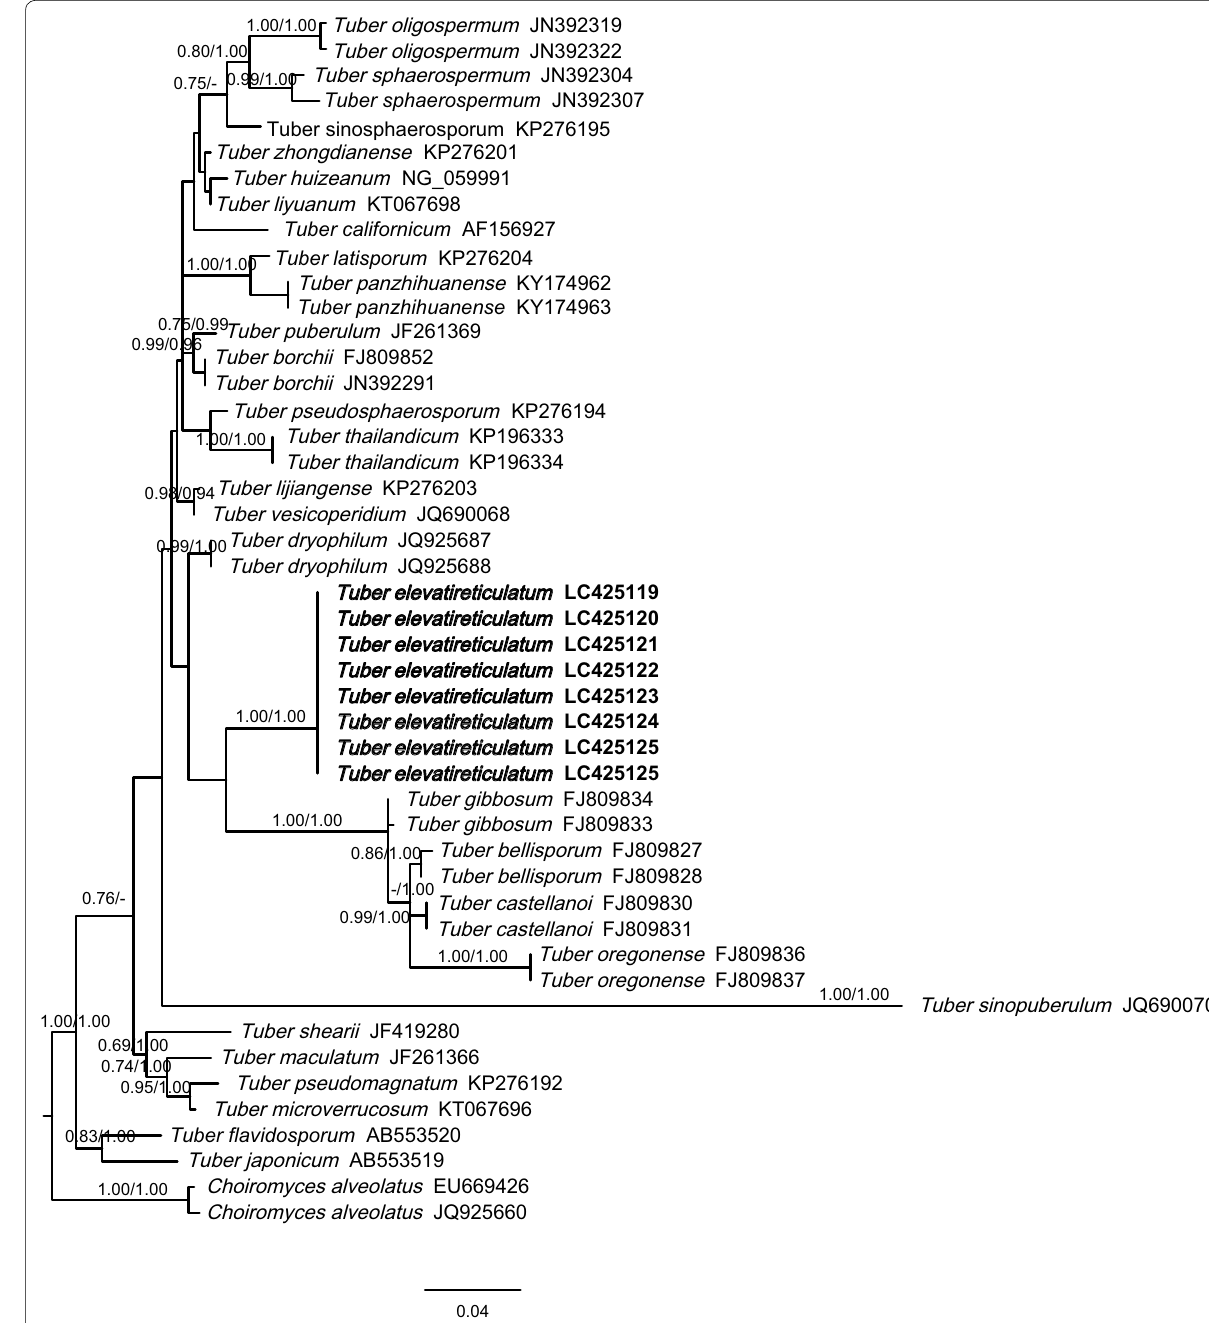
Fig. 3 Phylogenetic tree of Tuber elevatireticulatum and related whitish truffles based on the LSU‑rDNA sequences. Choiromyces alveolatus was used as the outgroup taxa. Numbers identify the bootstrap values and Bayesian posterior probabilities are indicated near branches as BS/PP. Values of BS and PP below 50% are not indicated. The sequences of new species described in this study are bold as